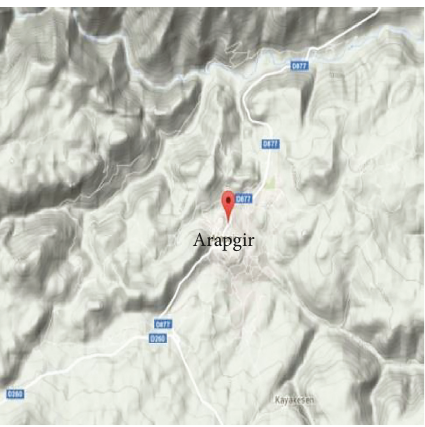
Figure 2: Satellite view of Arapgir Province. Table 1: Monthly average wind speed measured at 10m height. Average wind speed at Figure 3: Wind rose belonging to Arapgir Month